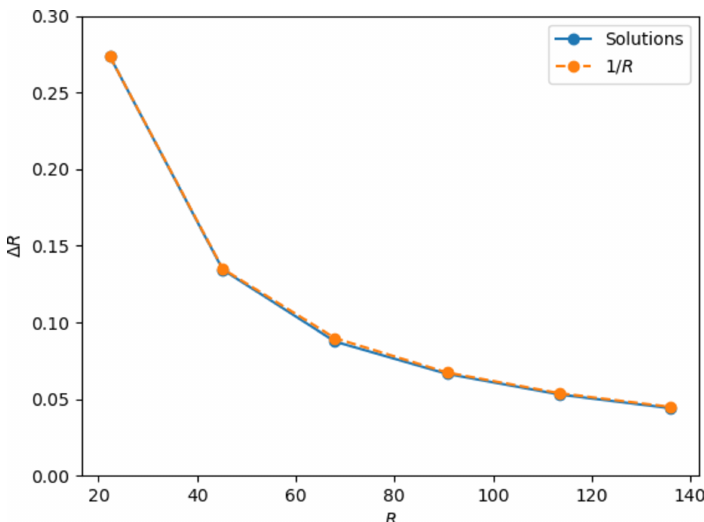
Figure 13 . The radius splitting as a function of the radius (as measured by the core of the string) using parameter set B, with Q/N = 31 . 89 kept constant. The effect is reduced for larger vortons (higher N ) and appears to be inversely proportional to the radius. This is consistent with there being a curvature correction to the thin string